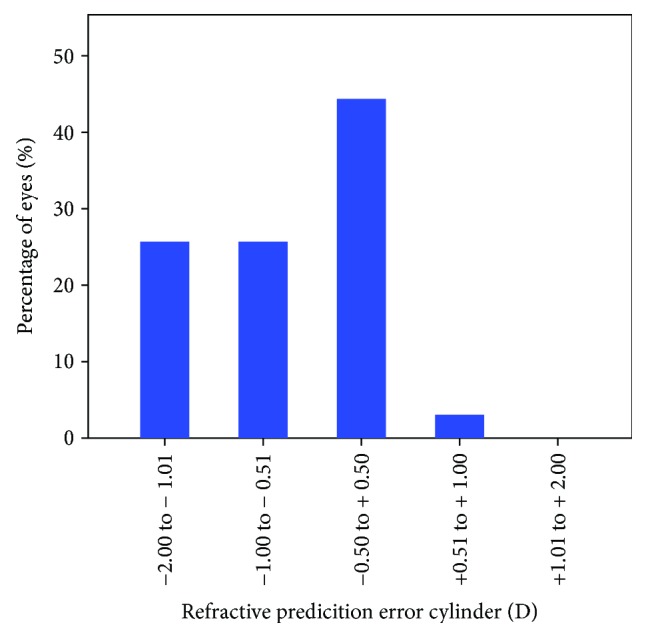
Percentage of eyes within a certain range of refractive predication error (cylinder) when using a standard industry-based calculator.